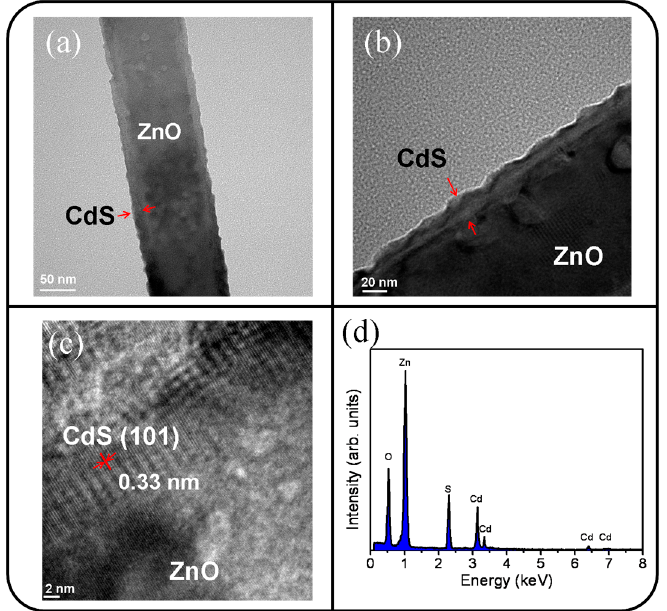
Figure 4. TEM analyses of the ZnO-CdS nanorod annealed: ( a ) Low-magnification TEM image; ( b ) high-magnification image; ( c ) HRTEM image taken from the local regions of the nanorod; ( d ) EDS spectrum taken from the nanorod.